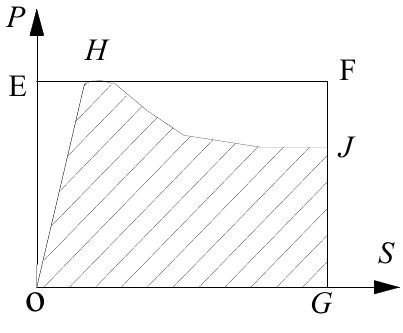
Figure 21. Energy dissipation area model.